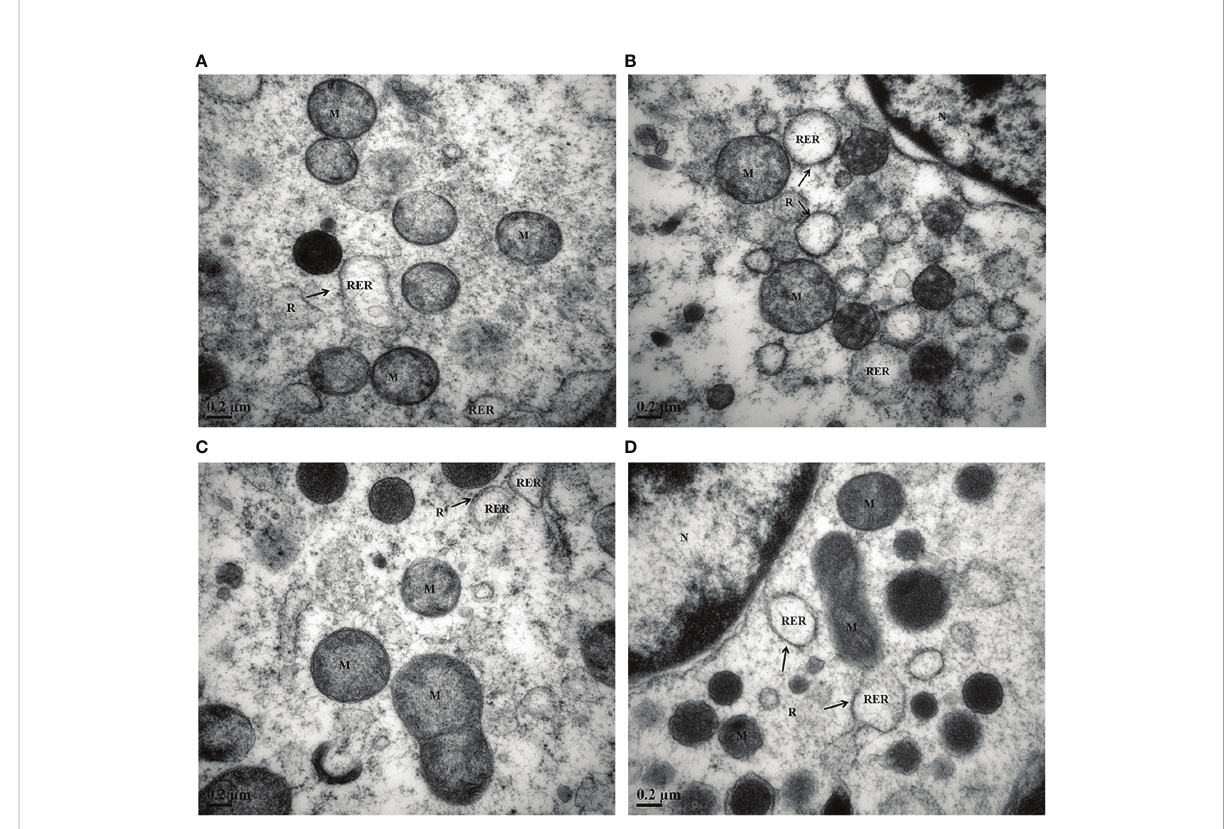
FIGURE 2 Transmission electron micrographs of the digestive gland of M. coruscus after exposure to MPs and P. lima for 72 h. (A) Control, (B) P. lima exposure, (C) 0.2 mg/L MPs exposure, (D) P. lima and 0.2 mg/L MPs exposure. M, mitochondria; RER, rough-surfaced endoplasmic reticulum; R, ribosome; Mag, ×50000, Scale bar: 0.2 m